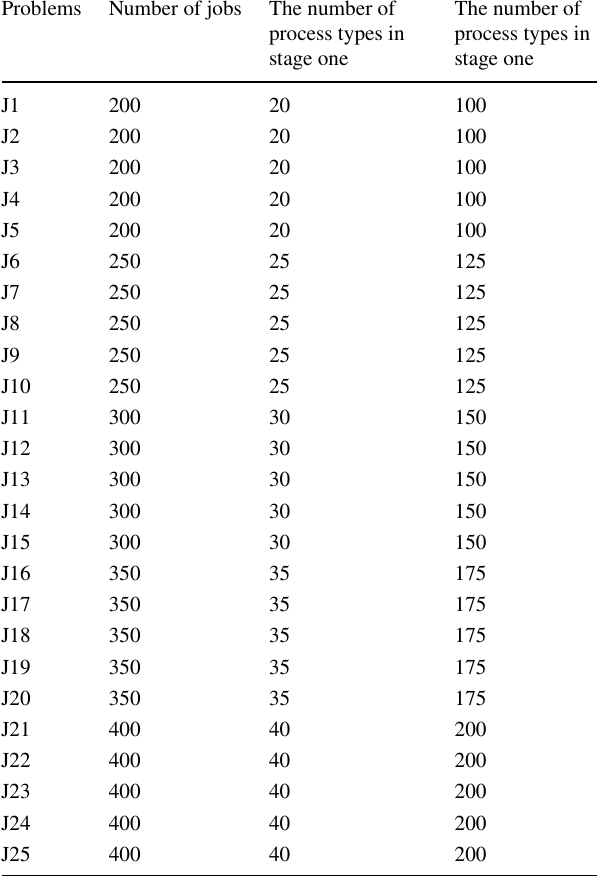
Table 1 The details of 25 scheduling problems